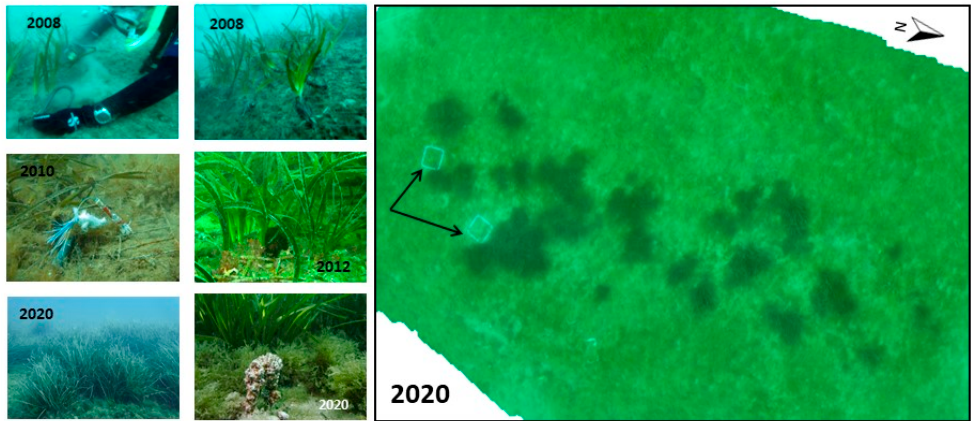
Figure 4. Photo mosaic of the reforestation pilot plant carried out on 11 May 2020 (on the right); black arrows indicate white 0.5 × 0.5 m squares. On the left, performance of the plant from 2008 to 2020. The below right photo shows the head of one of the several iron spikes in the foreground, used to anchor the metal grids in 2008 (above left photo), fully encrusted by biofouling. The 2010 photo highlights an additional source of disturbance (gear for octopus fishing trapped in the mesh of an implant grid) for pilot transplantation project